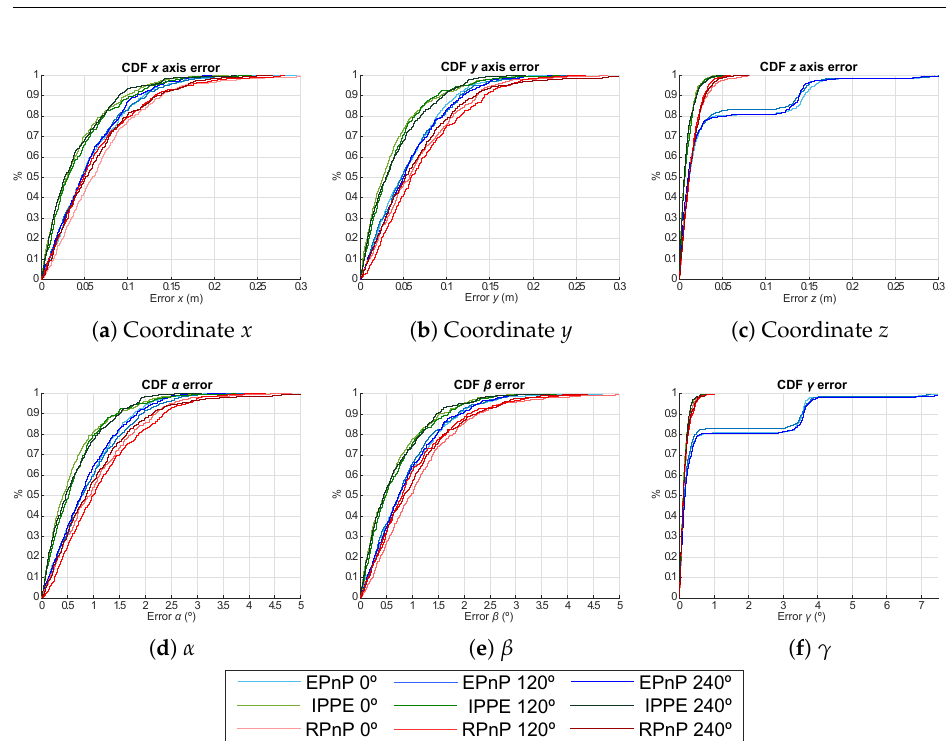
Figure 10. CDF of the absolute pose errors for EPnP, IPPE and RPnP algorithms and a rotation in the Z axis γ = {0 ◦ , 120 ◦ , 240 ◦ } when varying the location of a transmitter with a Gaussian noise σ =